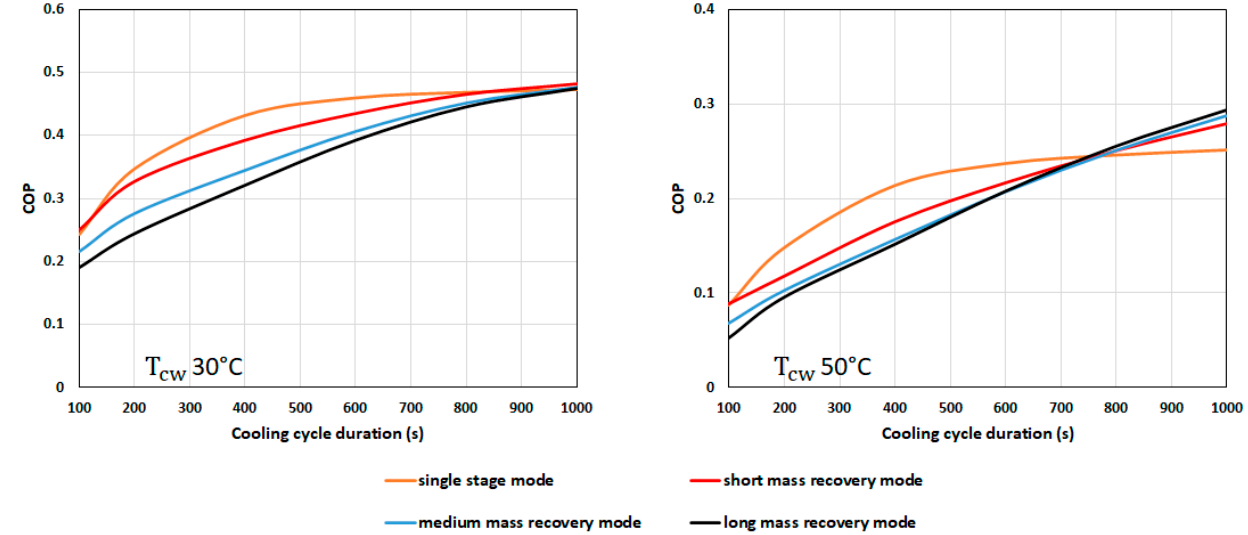
Figure 18. Predicted COP at various cycle mode and recooling water temperatures. Table 5. Optimum cycle time for each cycle